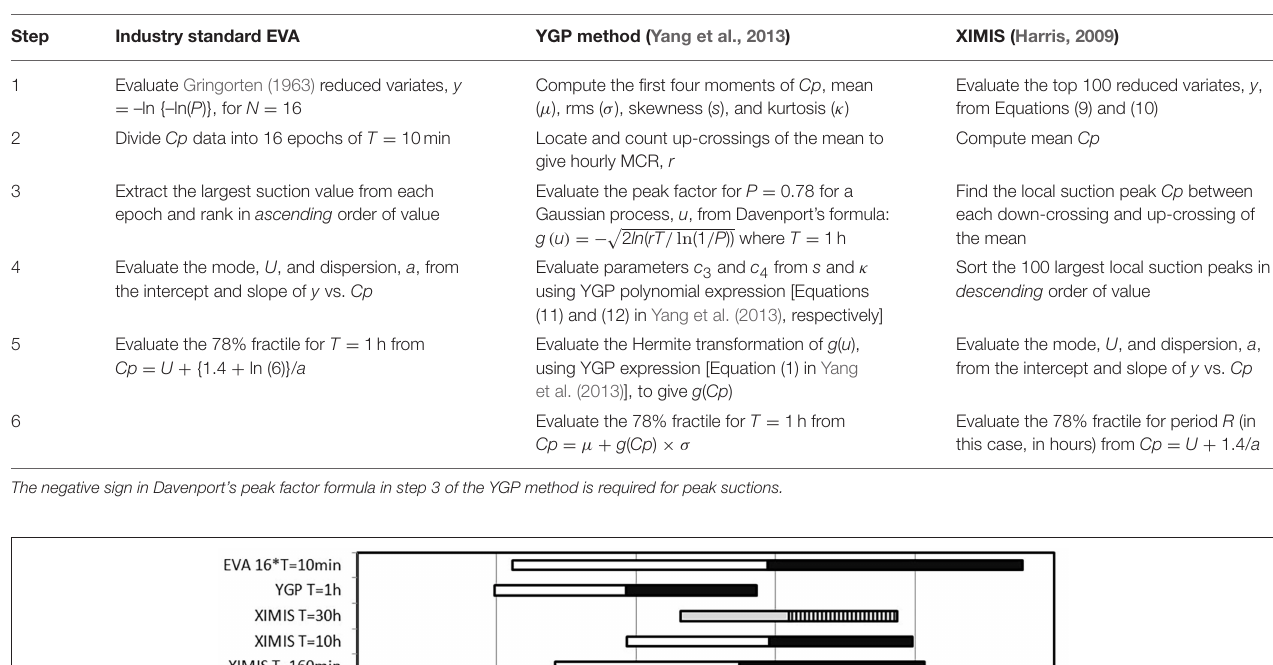
TABLE 1 | Evaluation steps for the three methods.